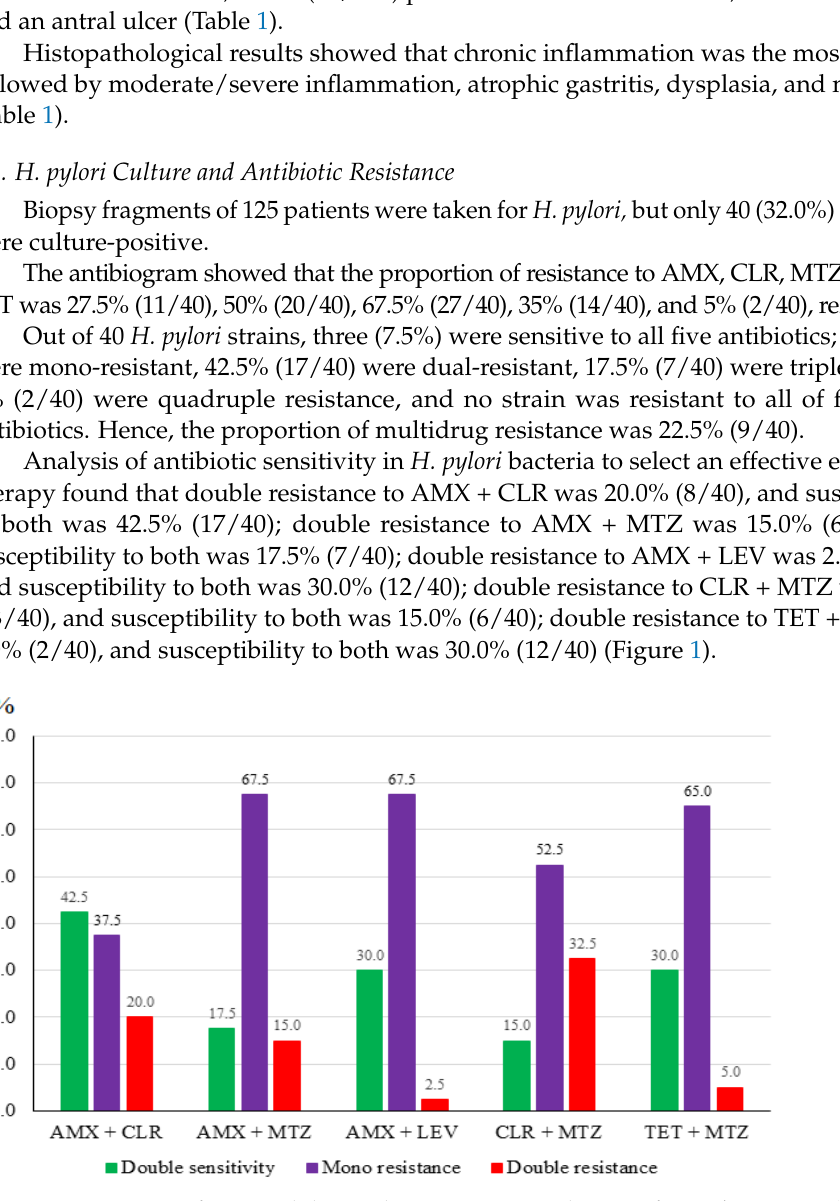
Figure 1. Frequency of susceptibility and resistance to antibiotics of H. pylori strains (amoxicillin (AMX), clarithromycin (CLR), metronidazole (MTZ), levofloxacin (LEV), and tetracycline (TET)).